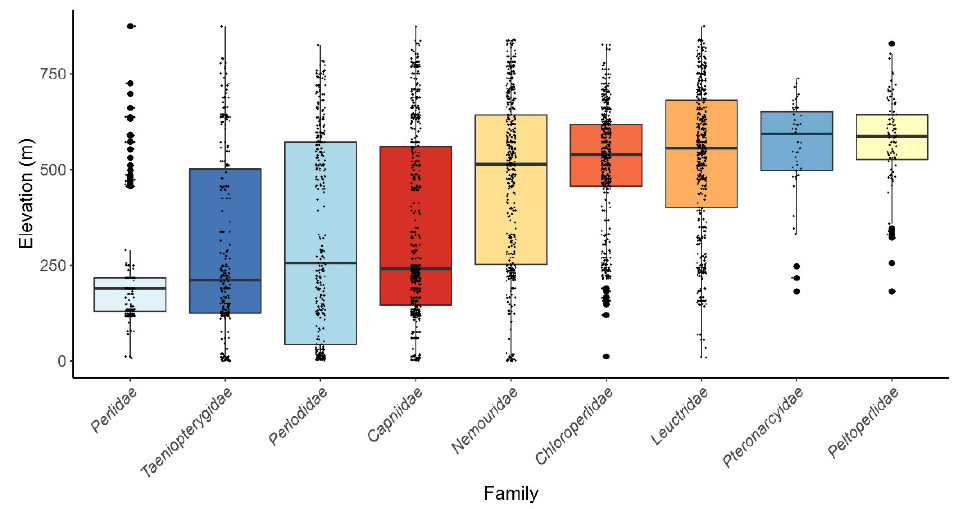
Figure 5. Boxplot of stonefly family elevation trends in Maryland. Boxes represent the interquartile range, while vertical lines extend to the minimum and maximum values. The horizontal line within the interquartile range represents the median elevation. Outliers are shown with large, solid circles. Small, individual points overlaid on each boxplot illustrate the distribution of observations.